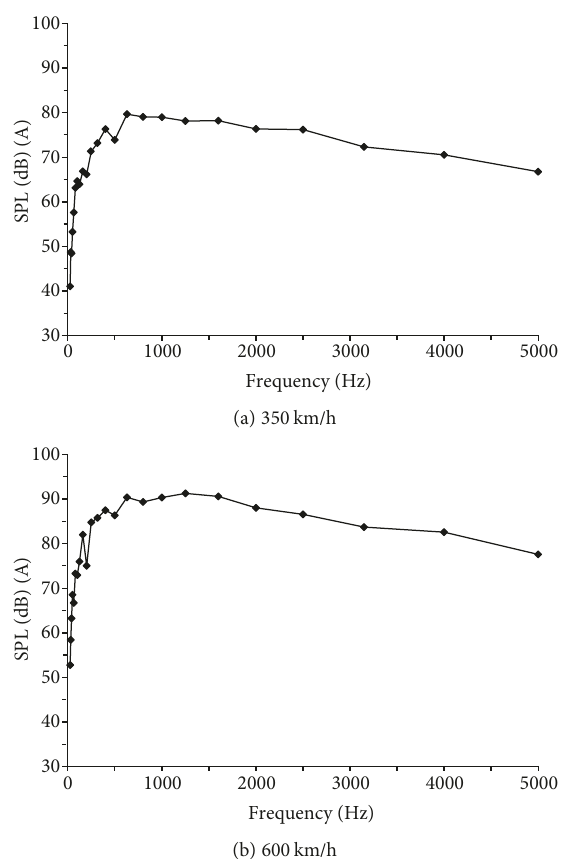
Figure 19: Comparison of sound pressure levels under 1/3